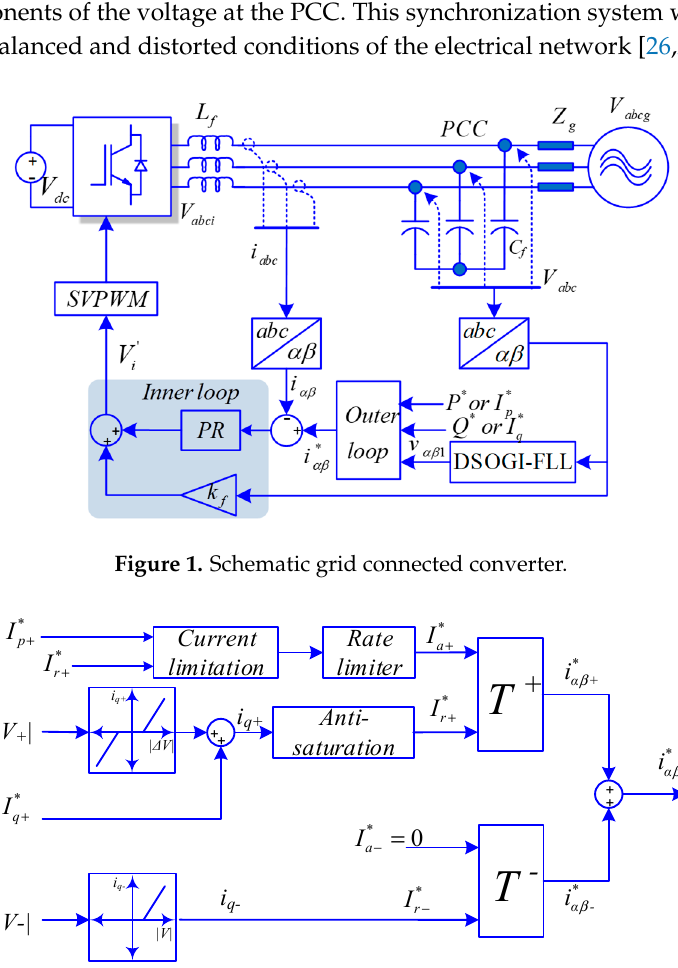
Figure 2. Schematic of the outer loop including the proposed anti-saturation scheme to generate the current reference.